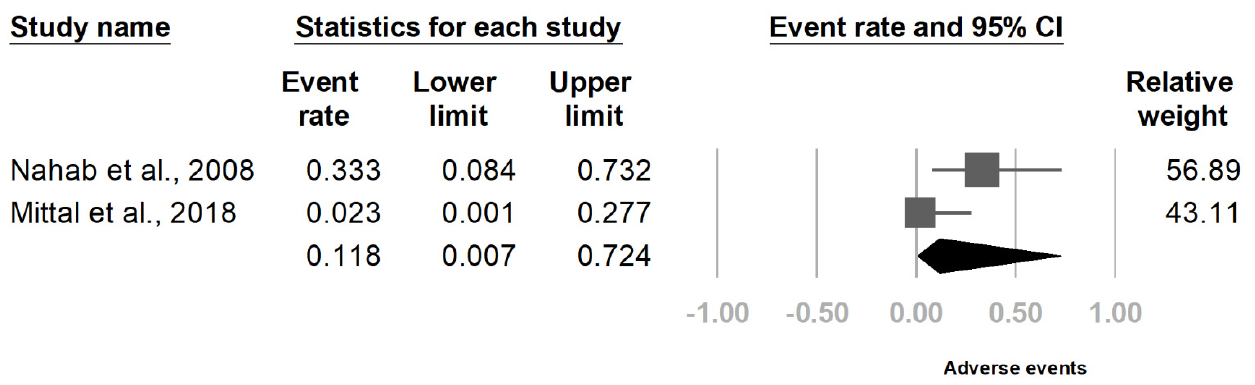
Figure 3. Forest plot of standardized mean differences in International Restless Legs Scale (IRLS) score. Squares indicate effect of individual studies, lines indicate 95% CI, and the diamond indicates the summarized effect size.